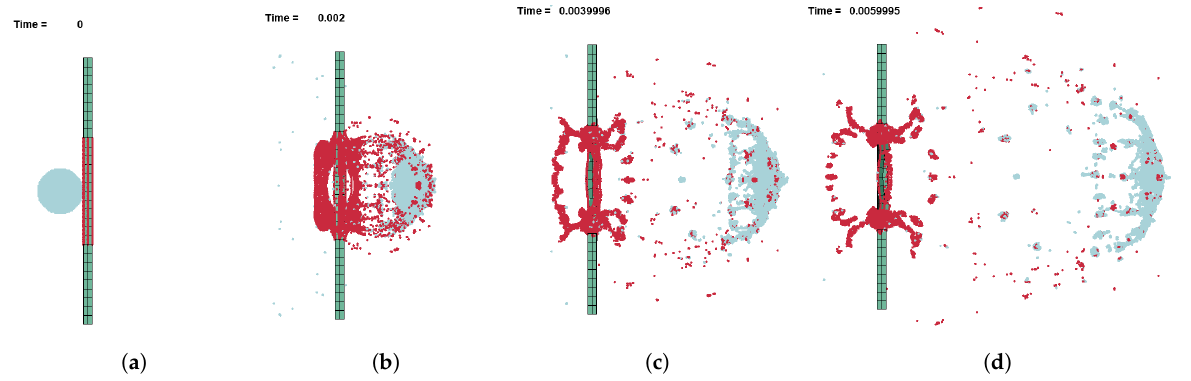
Figure 7. Simulation of standard Whipple shield model shown at: ( a ) t = 0 µ s, ( b ) t = 2 µ s, ( c ) t = 4 µ s, and ( d ) t = 6 µ s.